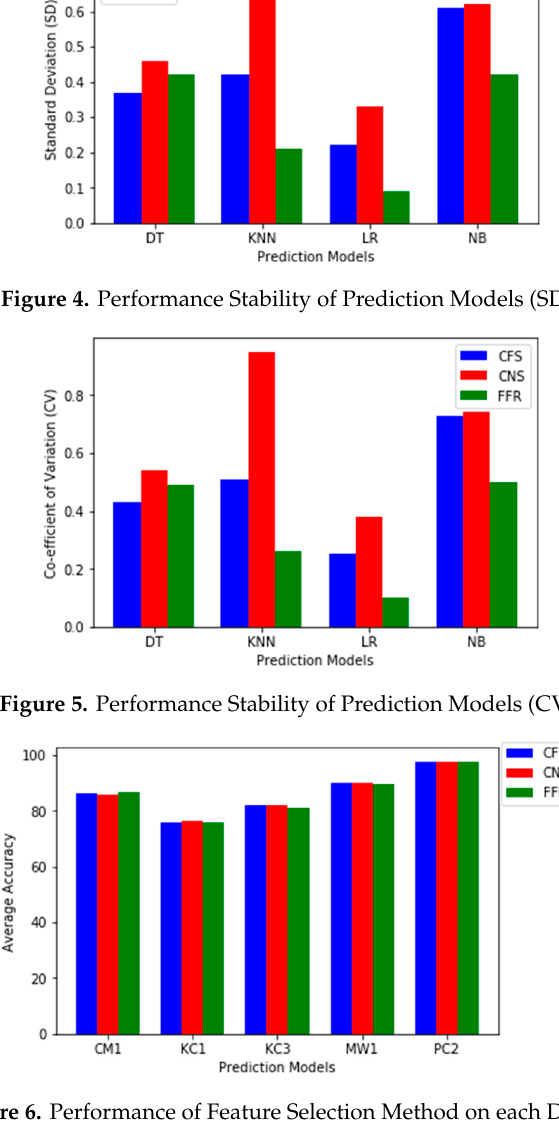
Figure 6. Performance of Feature Selection Method on each Dataset.